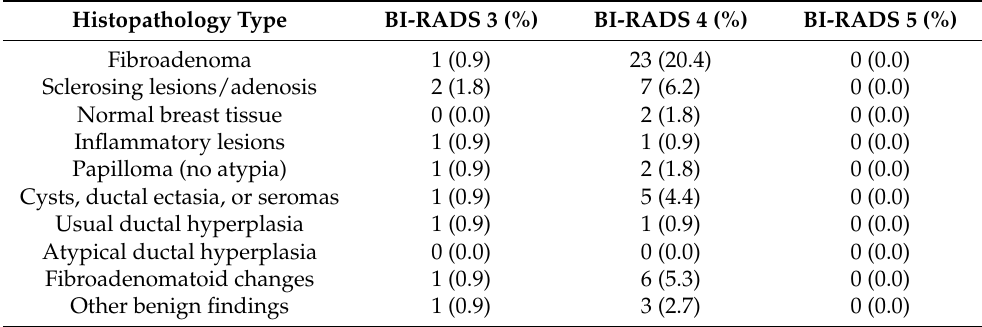
Table 7. Ensemble of support vector machines: BI-RADS diagnostic categories predicted for breast masses of the Testing set II according to histopathology